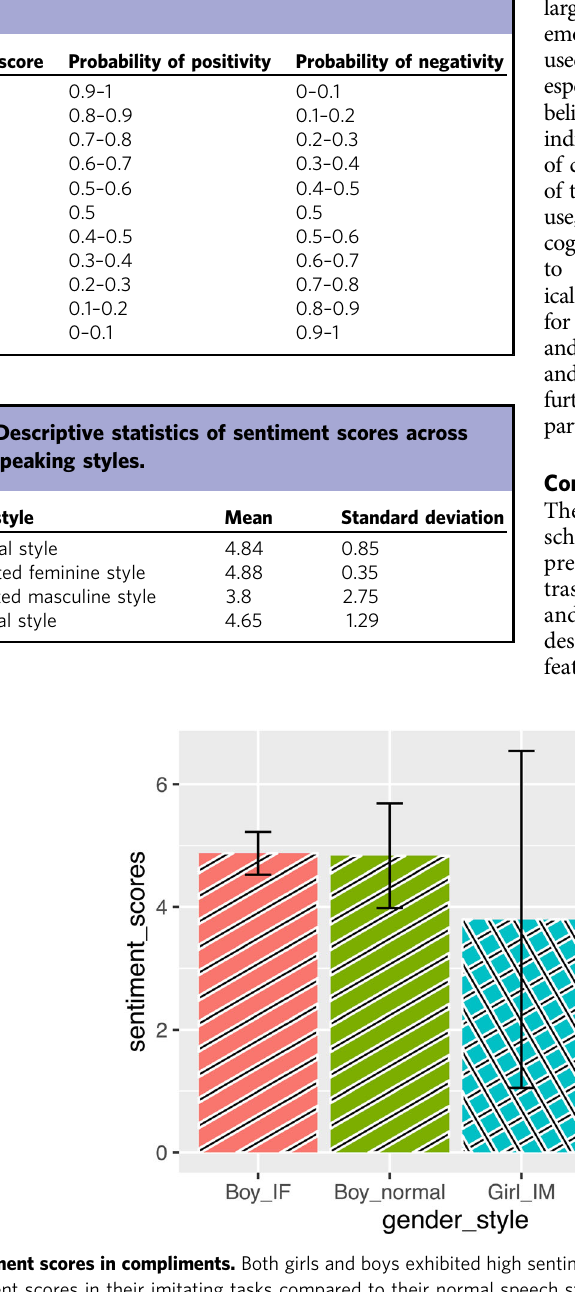
Table 14 Transformation of probability into sentiment scores.